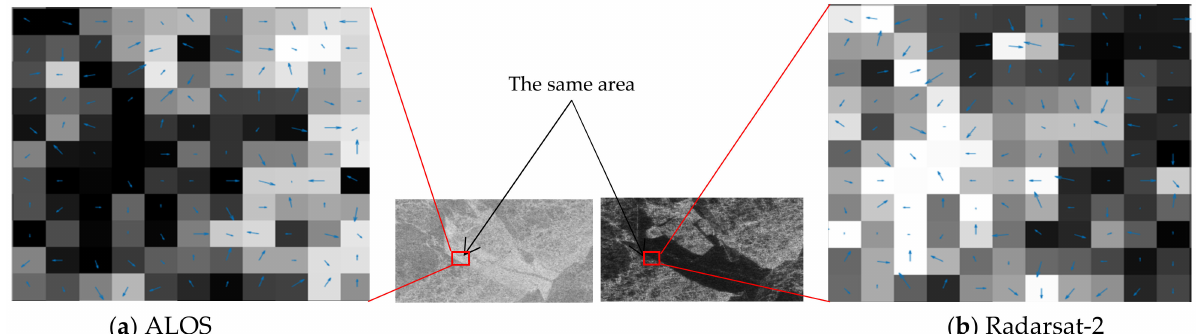
Figure 3. Gradient map of images with intensity difference. These two images are located at Mackenzie Trough, Beaufort Sea (Canada). The resolution of ASAR in stripmap mode is ten meters, and the resolution of Radarsat-2 in fine mode is eight meters. We downsampled the 8-m Radarsat-2 image to 10 m using a cubic convolution algorithm for uniform resolution. The incidence angle of Radarsat-2 is 48.5 ◦ , and the incidence angle of ASAR is 34.4 ◦